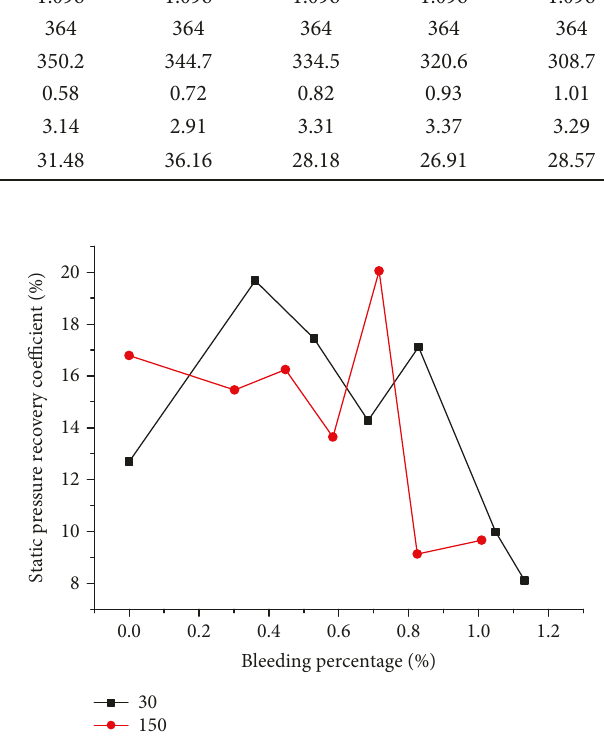
Figure 20: Relationship between the static pressure recovery coe ffi cient and the bleeding percentage (1.20 expansion